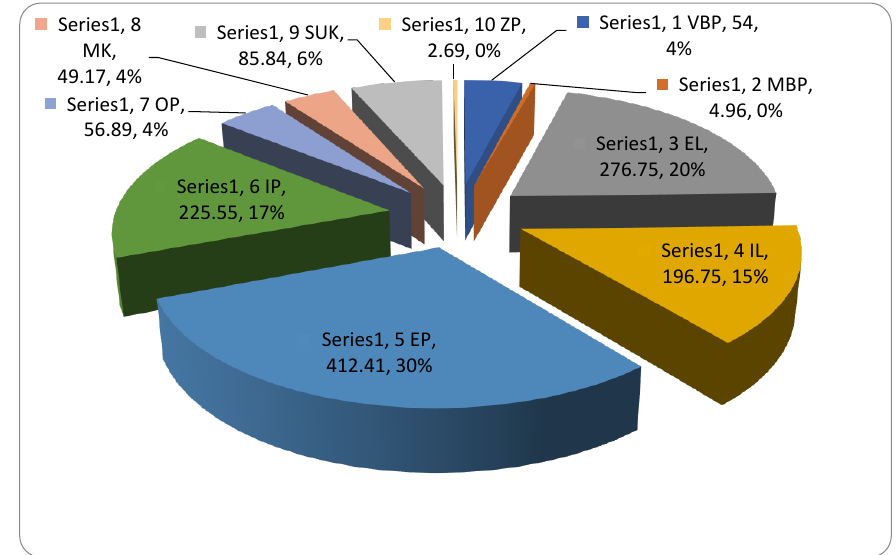
Figure 7. Percentage overview of the main types of landscape in the agricultural part of the study area. Legend: SBF—small-block fields, LBF—large-block fields, EM—extensively used